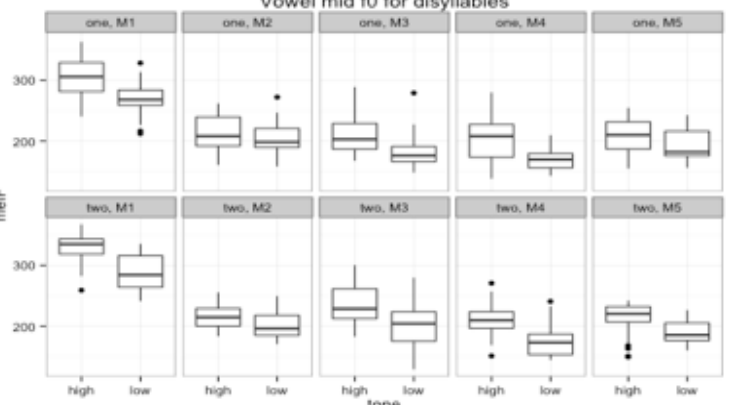
Figure 19: Mid vowel positions of the two vowels in disyllables. One indicates the vowel of the first syllable; two indicates the vowel of the second syllable. The differences are shown for individual